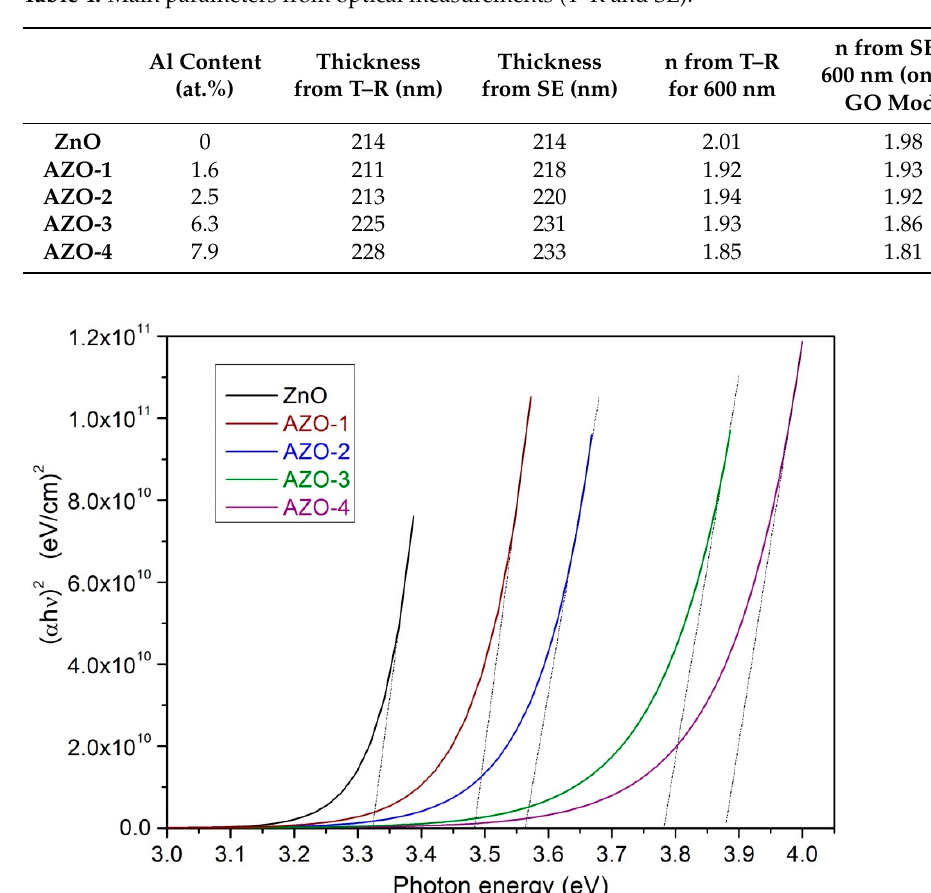
Table 4. Main parameters from optical measurements (T–R and SE).